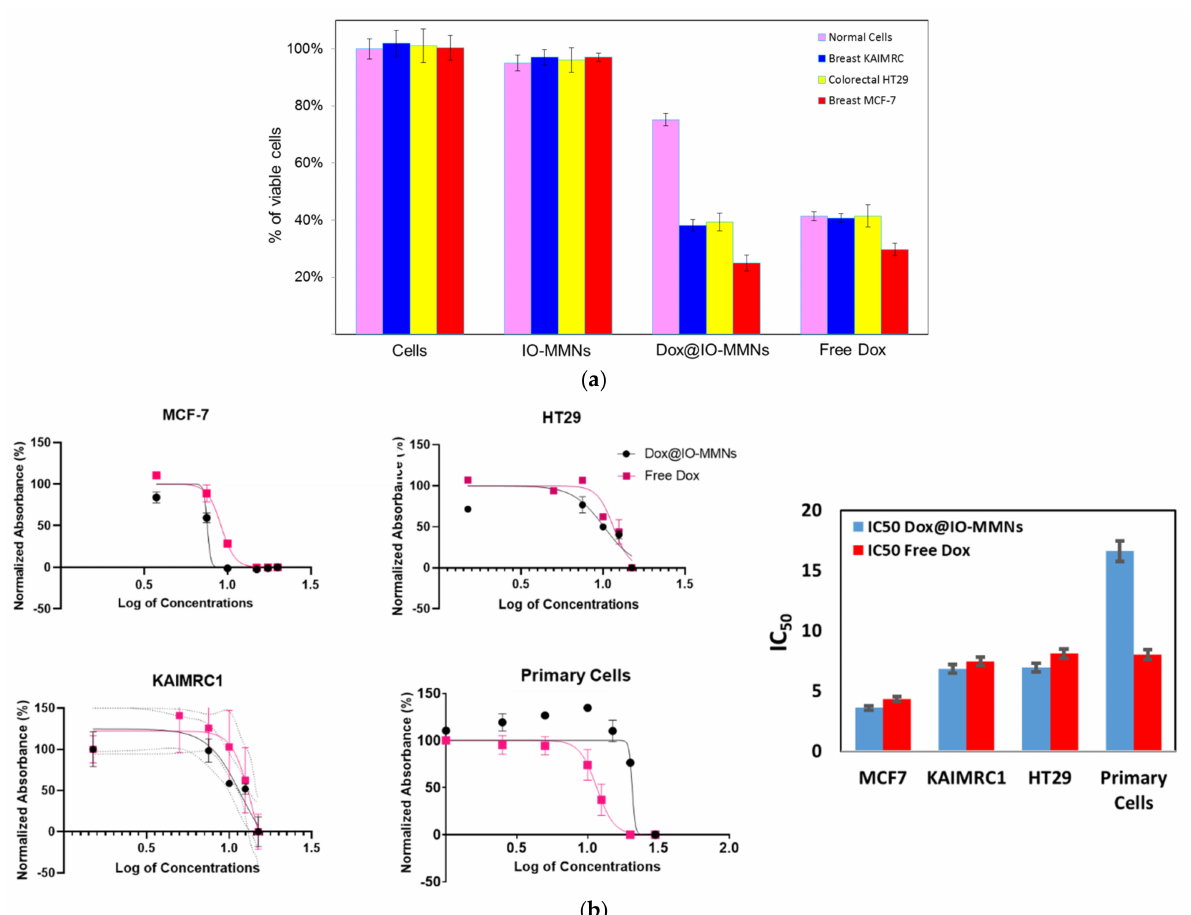
Figure 5. MTT cell viability assays for IO-MMNs, Dox@IO-MMNs, and free Dox with the various types of cancerous and primary normal cells. ( a ) Percentage of viable cells upon incubation with IO-MMNs (35 µ g/mL), free Dox (5 µ g/mL Dox), or Dox@IO-MMNs (35 µ g/mL IO-MMNs, 5 µ g/mL Dox) at the same concentrations. ( b ) Dose-dependent non-linear regression curves of the cytotoxicity assays on the different cancer cells as well as on normal primary cells determined using MTT assay. Results show that while free IO-MMNs display no substantial toxicity to any of the tested cells, Dox@IO-MMNs were found to be highly potent to the three cell lines with IC 50 values ranging from ~3.5 to 7 µ g/mL Dox content, and up to 4-fold more toxic as compared to normal cells (IC 50 ~16.6 µ g/mL Dox), being the least sensitive. Free Dox, however, at the same concentrations, equally killed all the tested cells including normal cells. x -axis: Log of concentrations expressed in µ g/mL; y -axis: absorbance at 450 nm. Triplicates were conducted and error bars denote standard